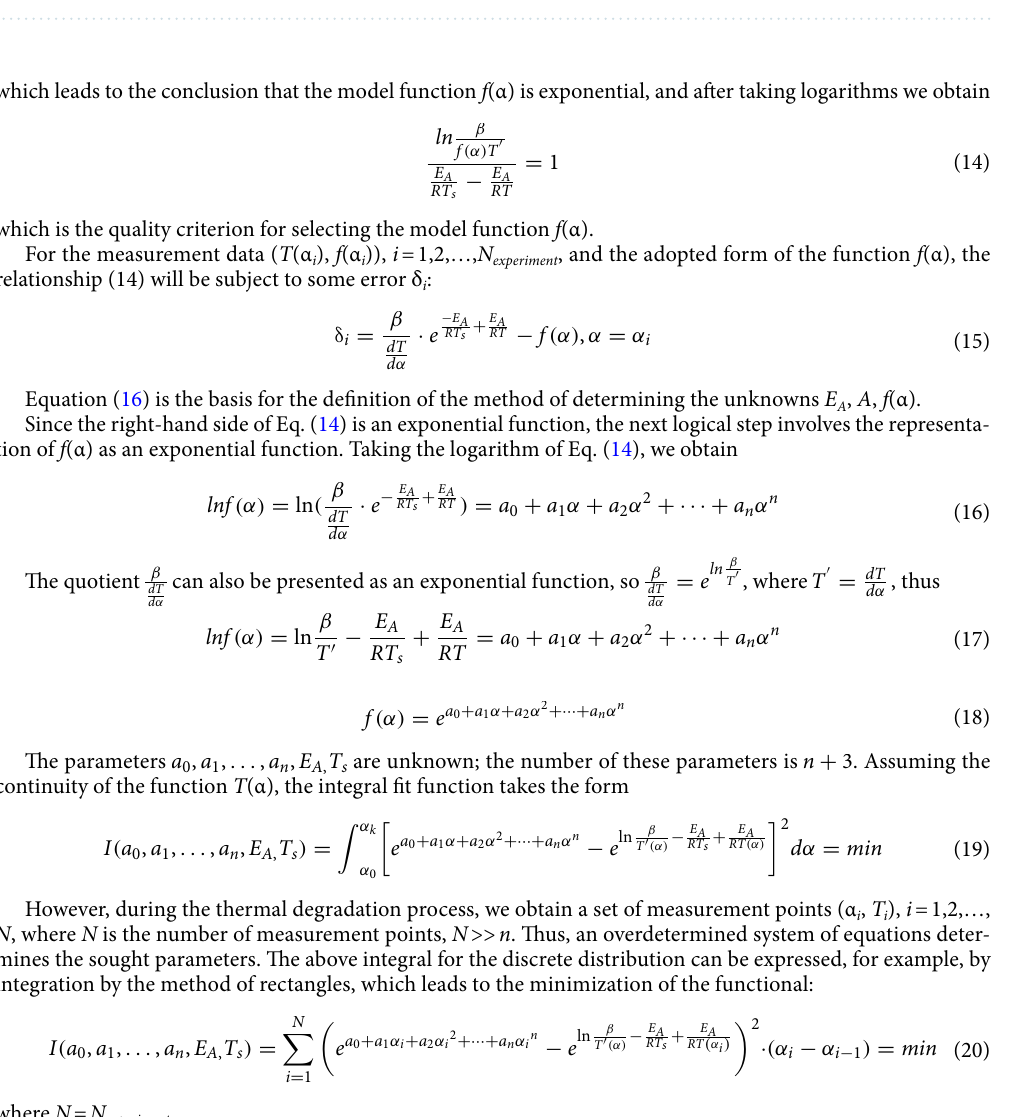
Figure 1. The idea of determining the temperature T s for calculation of the constant A